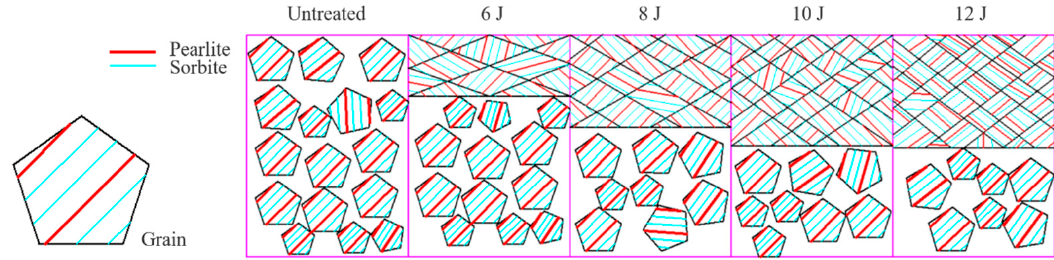
Figure 15. Schematic diagram of the microstructure changes of different pulse energies.